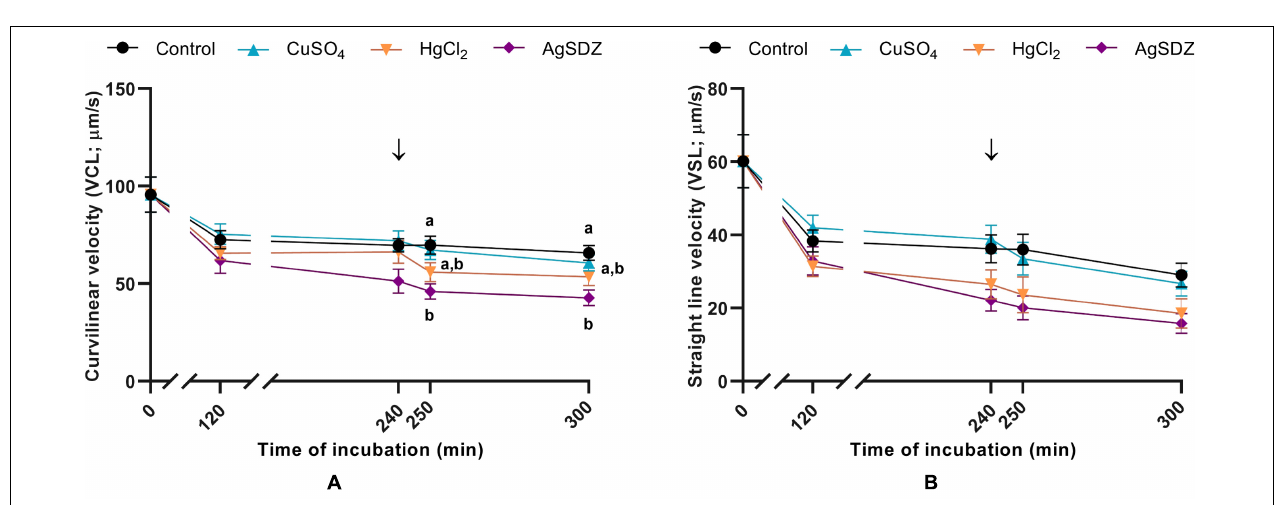
FIGURE 1 | Sperm motility and viability. (A) Percentages of progressively motile sperm within the population of motile cells (%) and (B) sperm viability measured as the percentage of spermatozoa with an intact plasma membrane (%) in samples exposed to the presence or absence of different AQP inhibitors in the capacitation medium: cooper sulfate (CuSO 4 ), mercury chloride (HgCl 2 ) and silver sulfadiazine (AgSDZ). Data were collected after 0, 120 and 240 min of incubation in capacitation medium. At this point, progesterone was added to capacitation medium (arrow) and data were collected after further 10 min and 60 min of incubation. Data are shown as mean ± SEM, and different letters (a,b) indicate significant differences ( P < 0.05) between different treatments within a given time point.